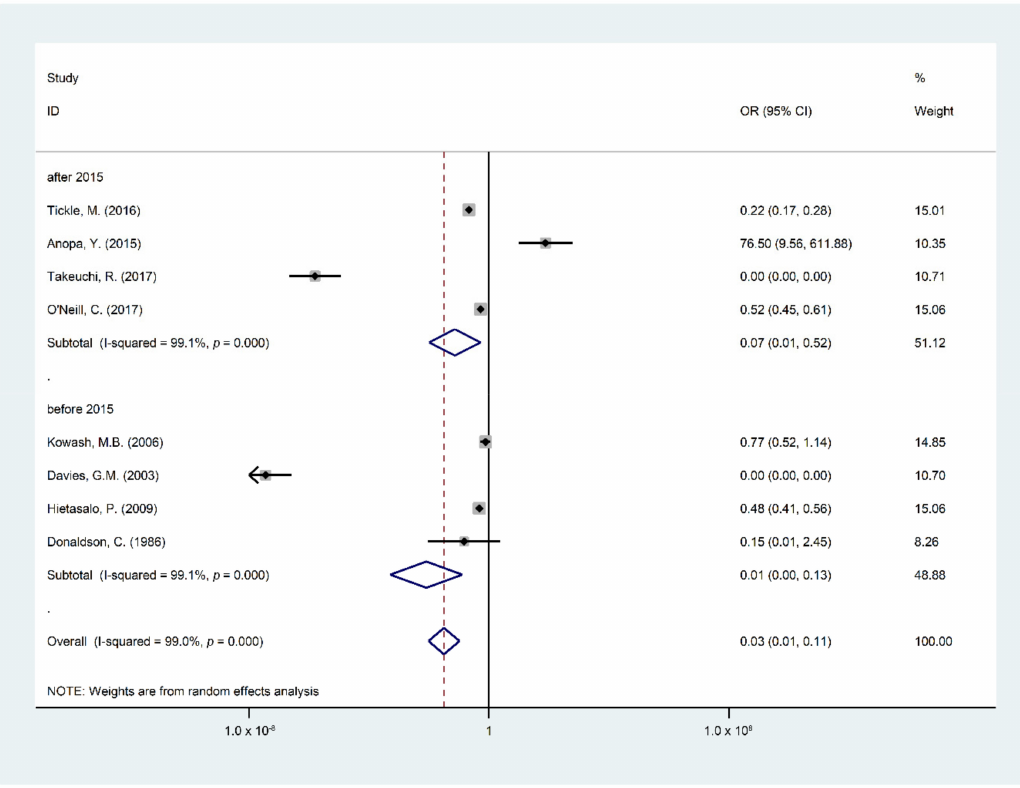
Figure 6. Forest plot for the di ff erence in the DMFT of the intervention group compared to the control group regarding the study